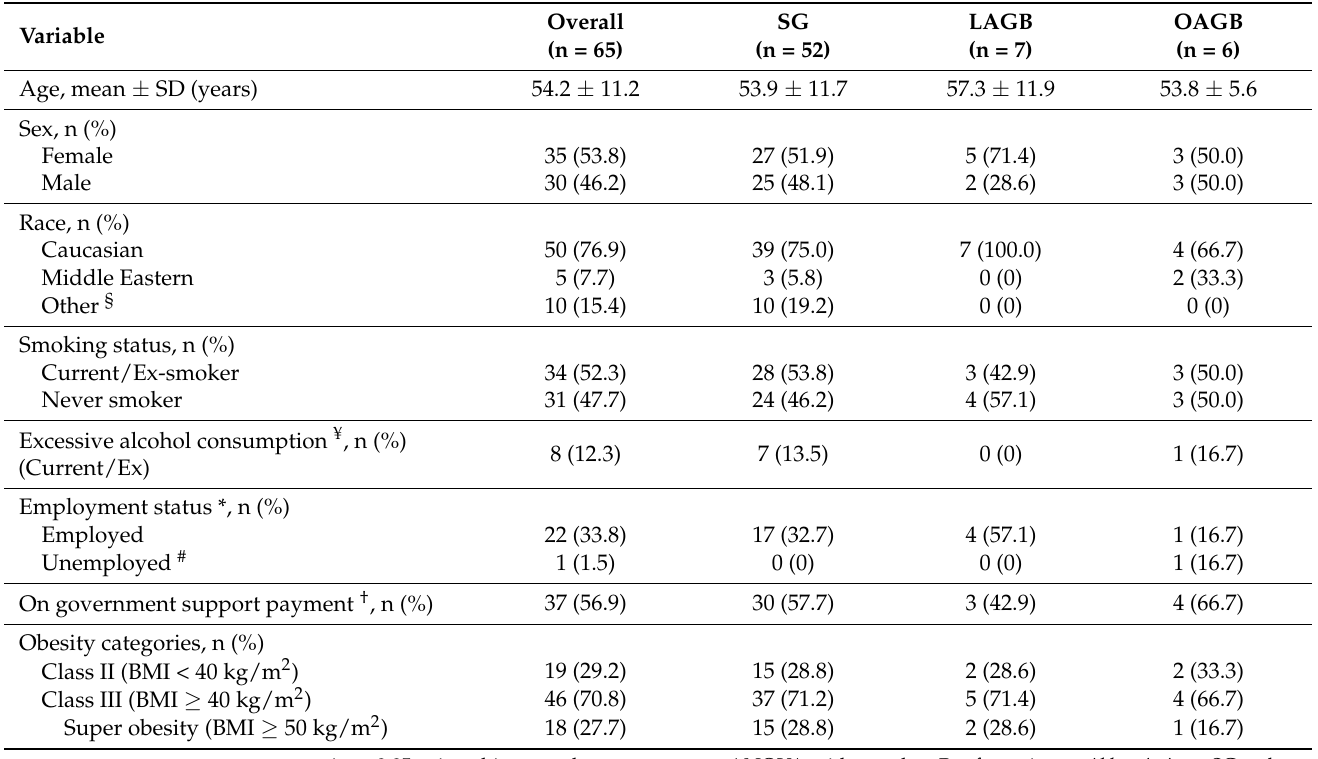
Table 1. Baseline sociodemographic and clinical characteristics of the study cohort by primary